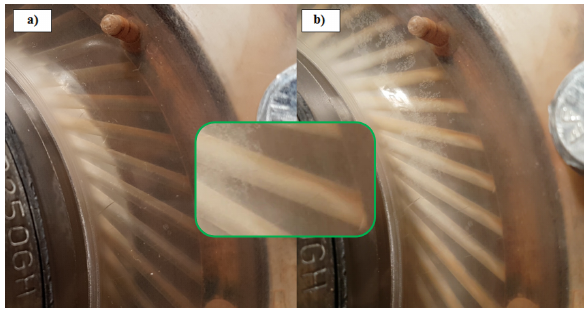
Figure 10: The cavitation in the grooved of the passive discs: a) no cavitation pump operation, b) supercavitation – enlarged view represents the vortex of super cavitation